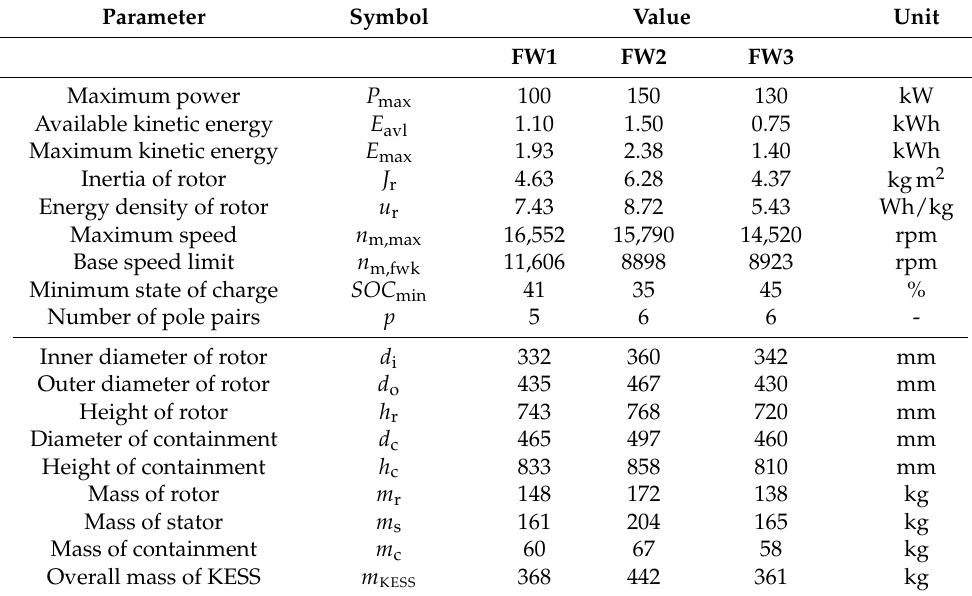
Table 4. Parameters of the mobile KESS